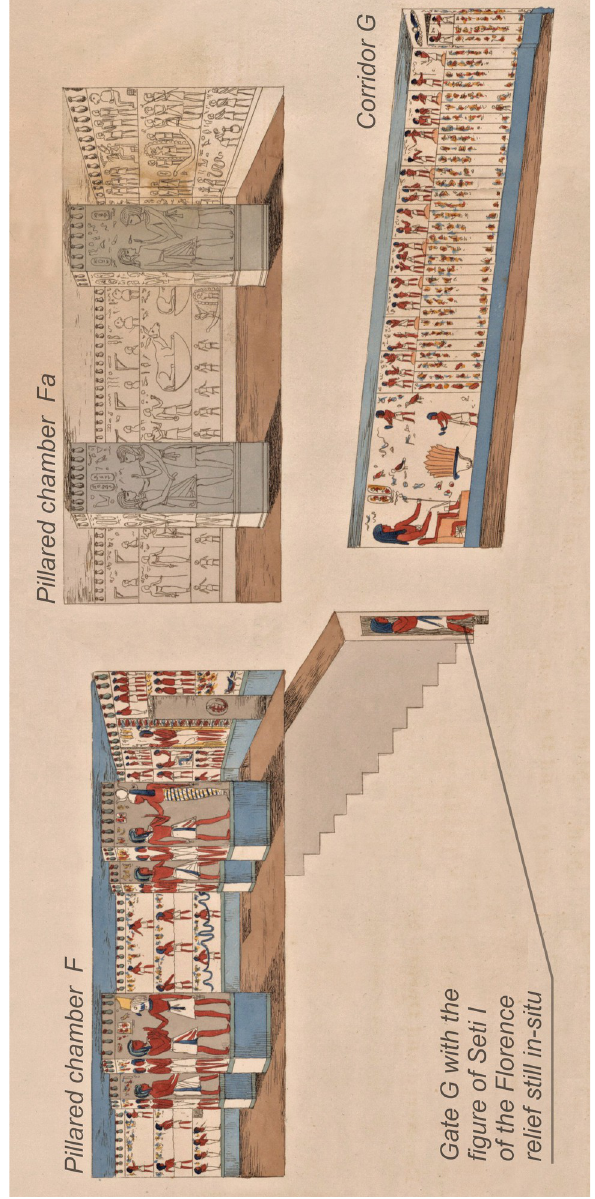
Figure 2. Section of the tomb published by Belzoni. The jambs of the gate G are still in place. The relief kept in Florence is partly visible. (Elaboration from Belzoni, 1820, pl.